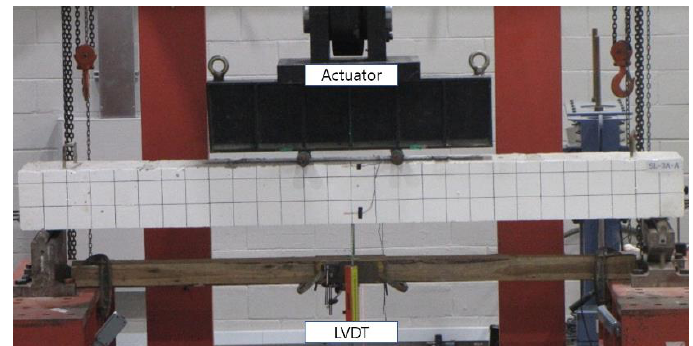
Figure 6. Test set-up.